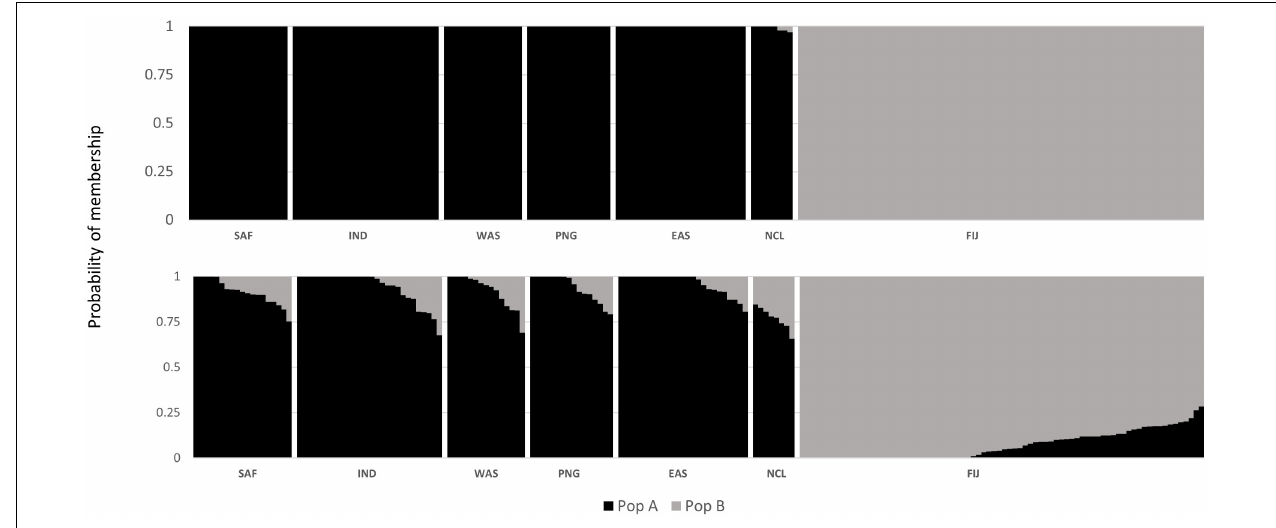
FIGURE 3 | Probability of population placement based on an optimal k of PopAssign (top) and Admixture (bottom) .